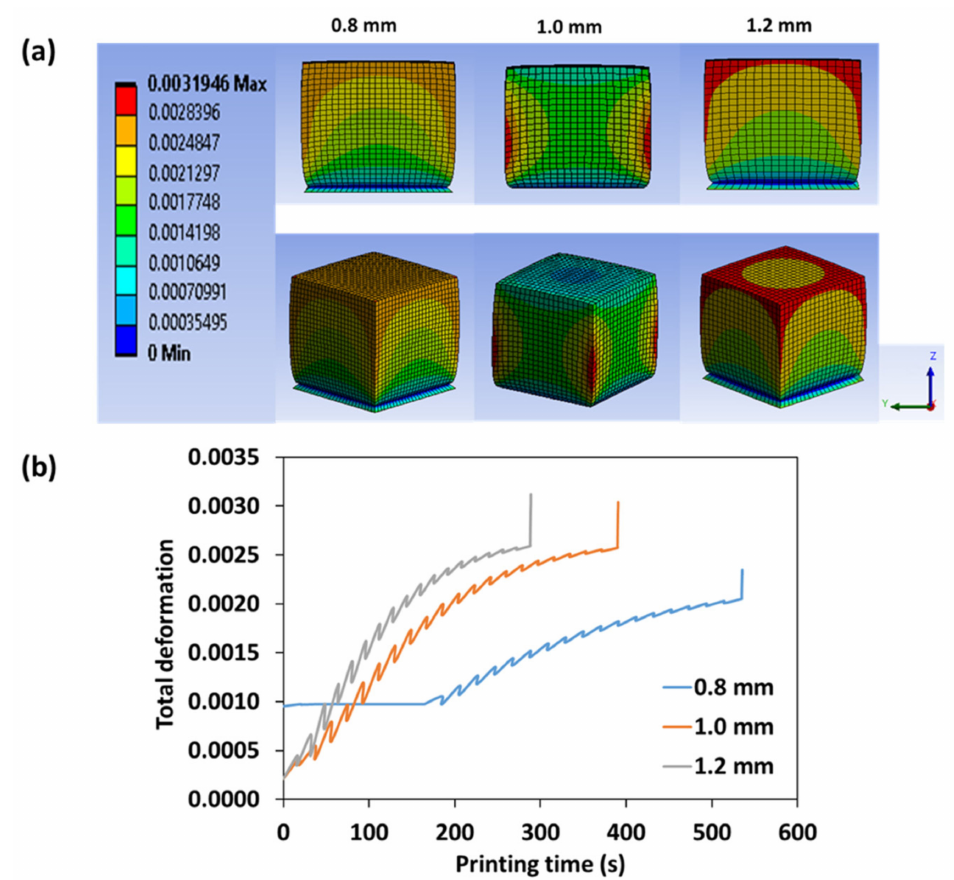
Figure 17. Total perpendicular deformation in a controlled environment temperature ( a ), and after structure-printing completion dependent on nozzle diameter ( b